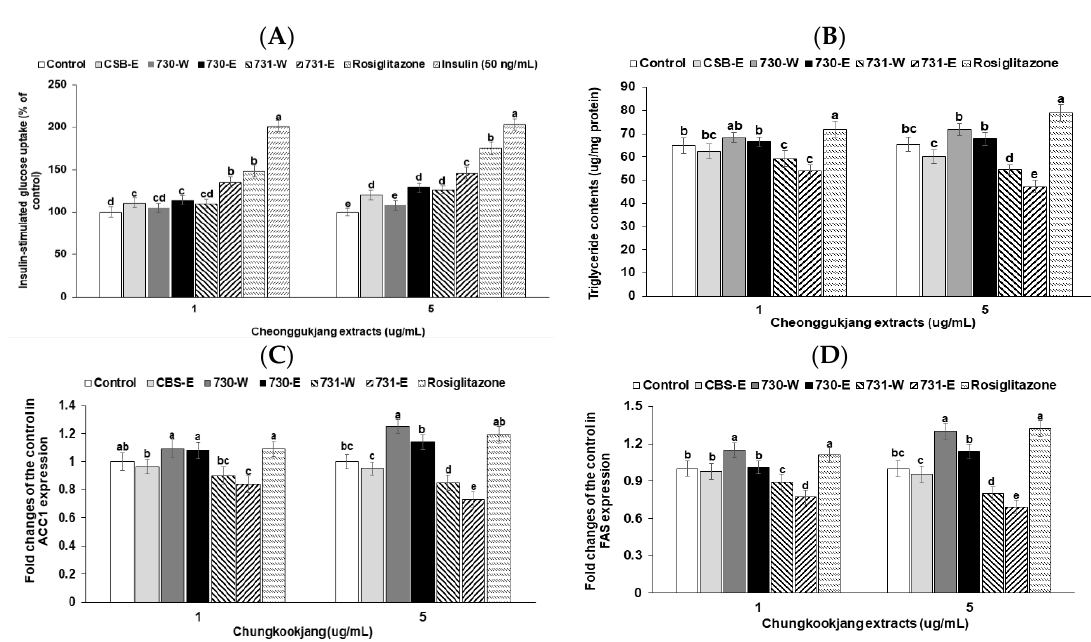
Figure 2. Insulin-stimulated glucose uptake, triglyceride deposition and expression of genes related to fatty acid synthesis in 3T3-L1 adipocytes. 3T3-L1 adipocytes were pre-treated with the 48 h-treatment of the ethanol (-E) and water (-W) extracts (1 and 5 µ g/mL) of chungkookjang fermented with B. amyloliquefaciens SRCM100730 (BA730) and SRCM10073 (BA731). ( A ) Insulin-stimulated glucose uptake was measured with low dosage (1 ng/mL) of insulin. Insulin treatment of 50 ng/mL was considered as normal-control. ( B ) Triacylglycerol contents were determined in 3T3-L1 adipocytes after 9–10 days of differentiating from 3T3-L1 fibroblast with differentiation inducers and vehicle, 1 or 5 µ g · mL − 1 of ethanol (-E) or water (-W) extracts of BA730 and BA731. ( C , D ) The fold changes of mRNA levels of genes associated with fatty acid metabolism (ACC1 and FAS) from the control were calculated by the 2 − ∆∆ CT method after conducting real-time PCR. The control and positive control were used as ethanol extracts of cooked soybeans and rosiglitazone (0.5 or 2 µ M), respectively. Values are means ± SD ( n = 7). a,b,c,d,e Different letters above the bars indicate significant differences among the groups by Tukey’s test at p <